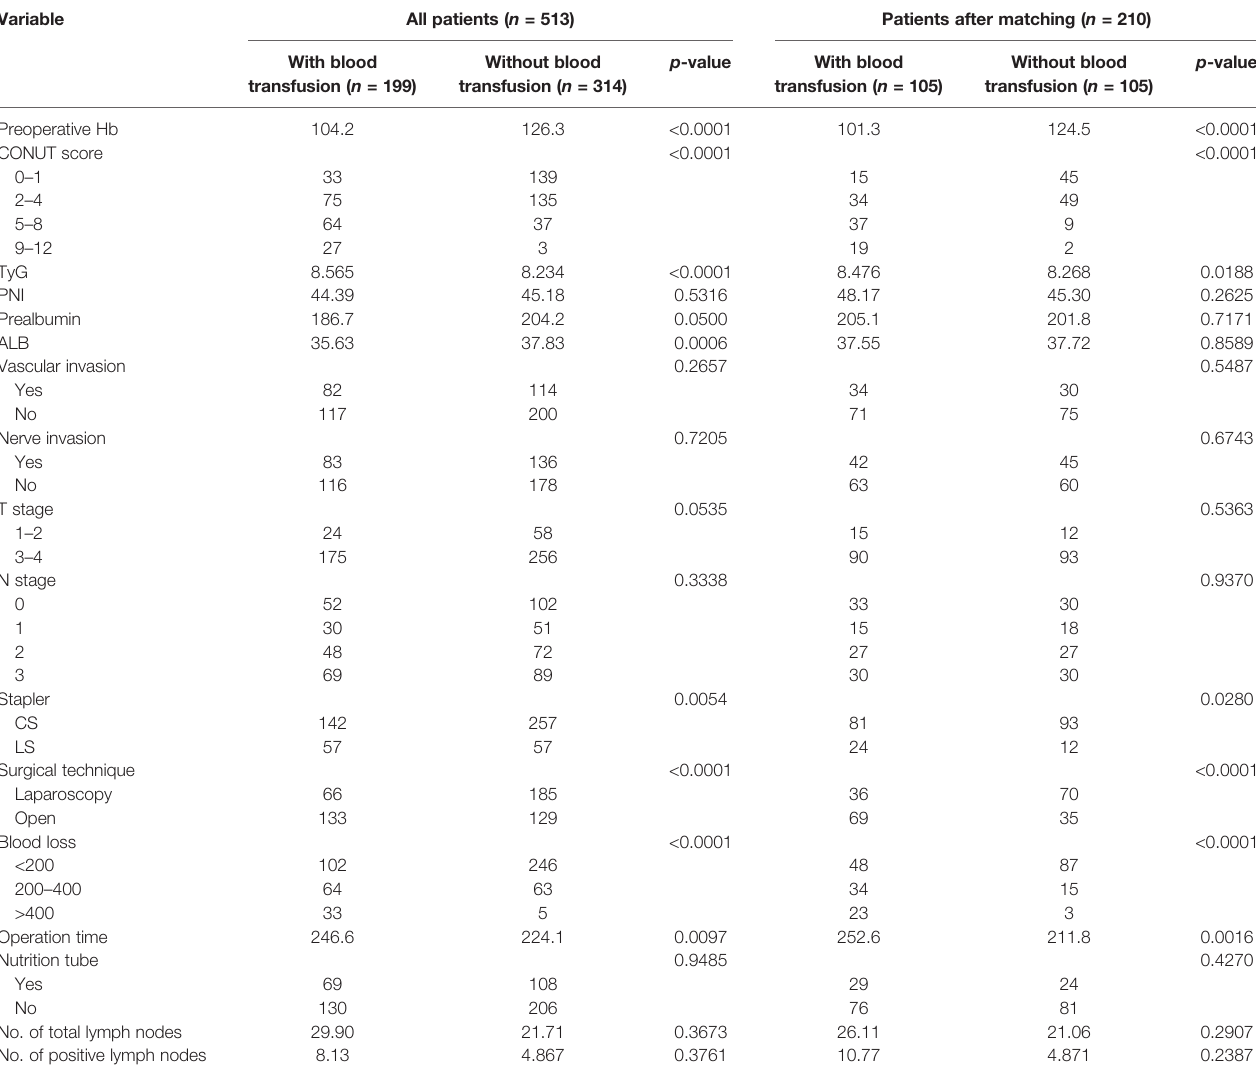
TABLE 3 | Comparison of the clinical, pathological, and surgical data of patients. Variable All patients ( n =